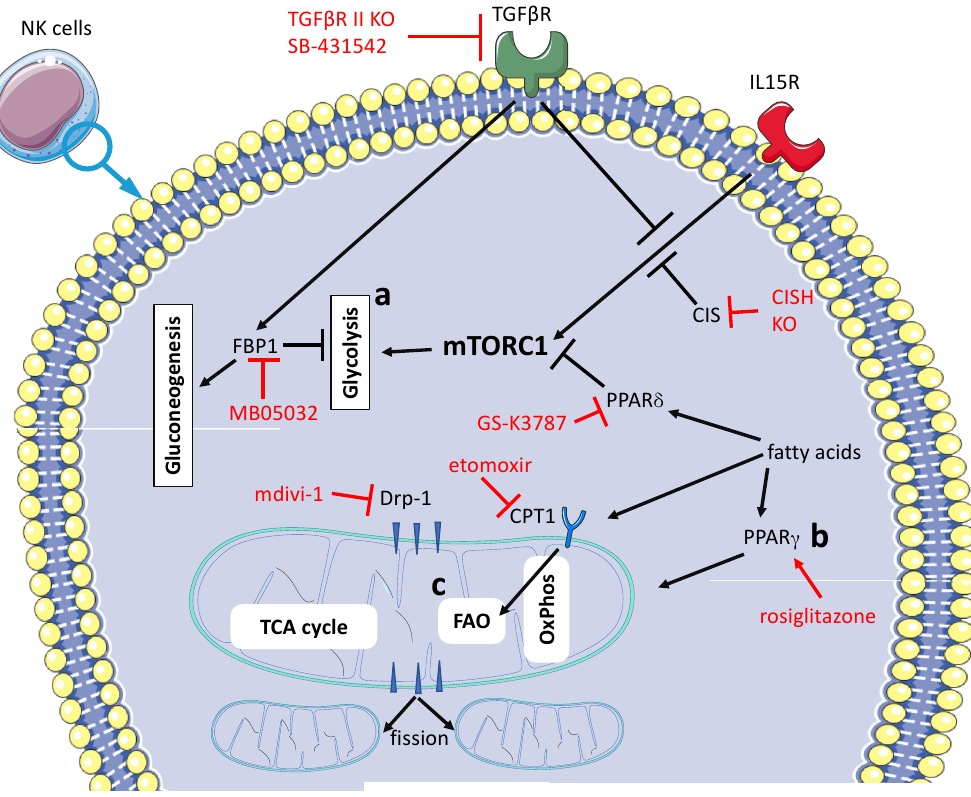
Figure 2. Pharmacological treatments or transgenesis aimed at restoring in the TME the anti-tumor activity of NK cells’ three main targets . ( a ) Fostering glycolysis can be pursued by several approaches: inhibition of TGF β R signal transduction [96,97], over-activation of IL-15R signal transduction [98,99], inhibition of gluconeogenesis [76] and inhibition of PPAR δ [93]. In most cases, these interventions produce an activation of mTORC1. ( b ) Rescuing homeostasis of mitochondria through treatment with a PPAR γ agonist [100] or inhibition of Drp-1 [77]. ( c ) Inhibiting fatty acid oxidation [93]. Therapeutic interventions are outlined in red.